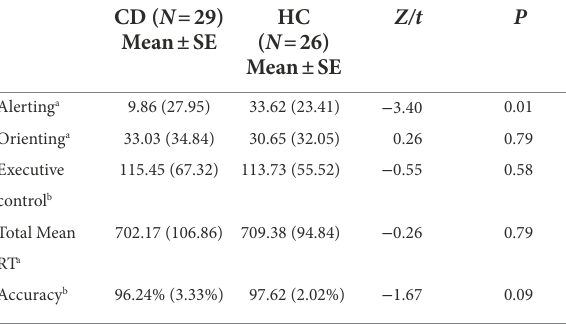
TABLE 3 Attention network scores (in RT) and accuracy (%) of CD patients and